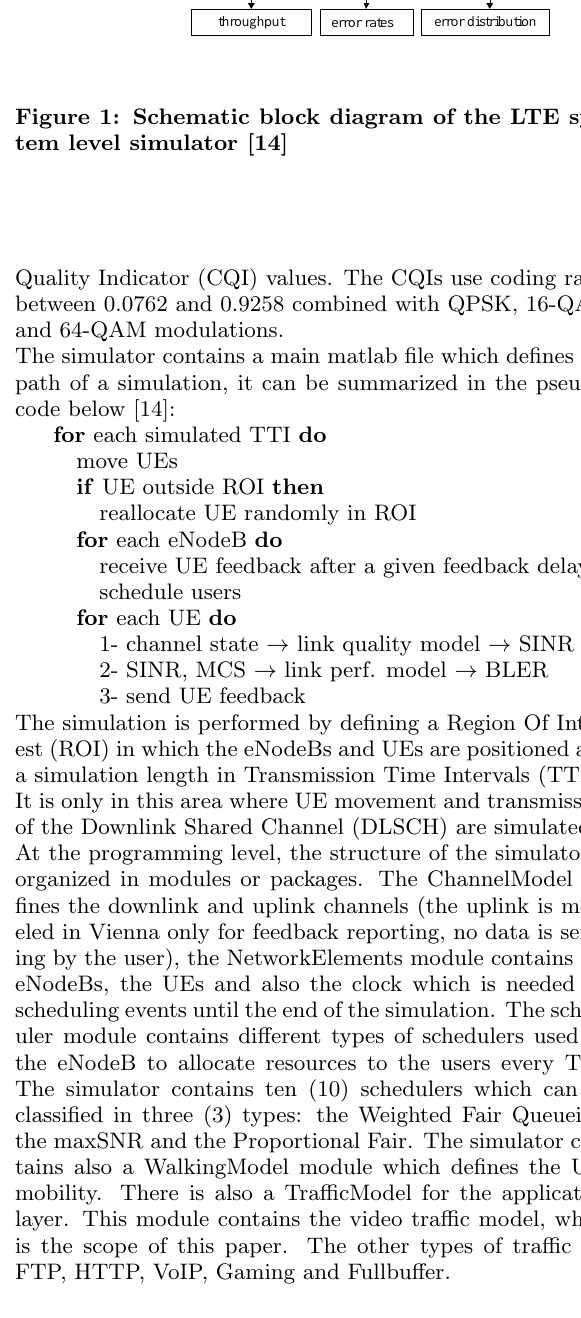
Figure 1: Schematic block diagram of the LTE sys- tem level simulator [14]